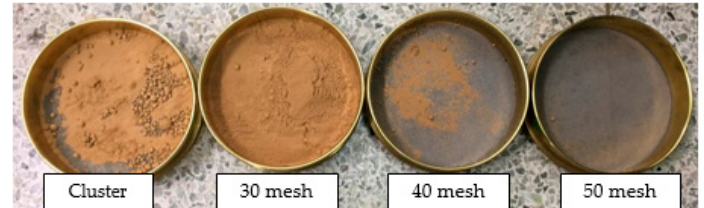
Figure 1. SOC particle size classification results.